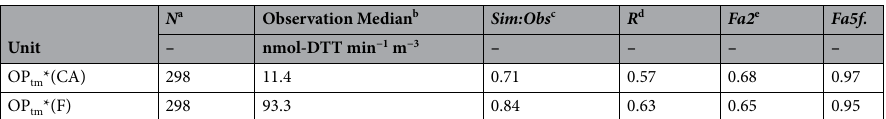
Table 1. Statistical metrics to compare the simulated (D02) and observed daily OP tm * values at Yonago. a Number of available data. b Median of the observation data. c Simulation to observation median ratio. d Correlation coefficient. e Fraction of the simulated values within a factor of two of the observed values. f Fraction of the simulated values within a factor of five of the observed values.